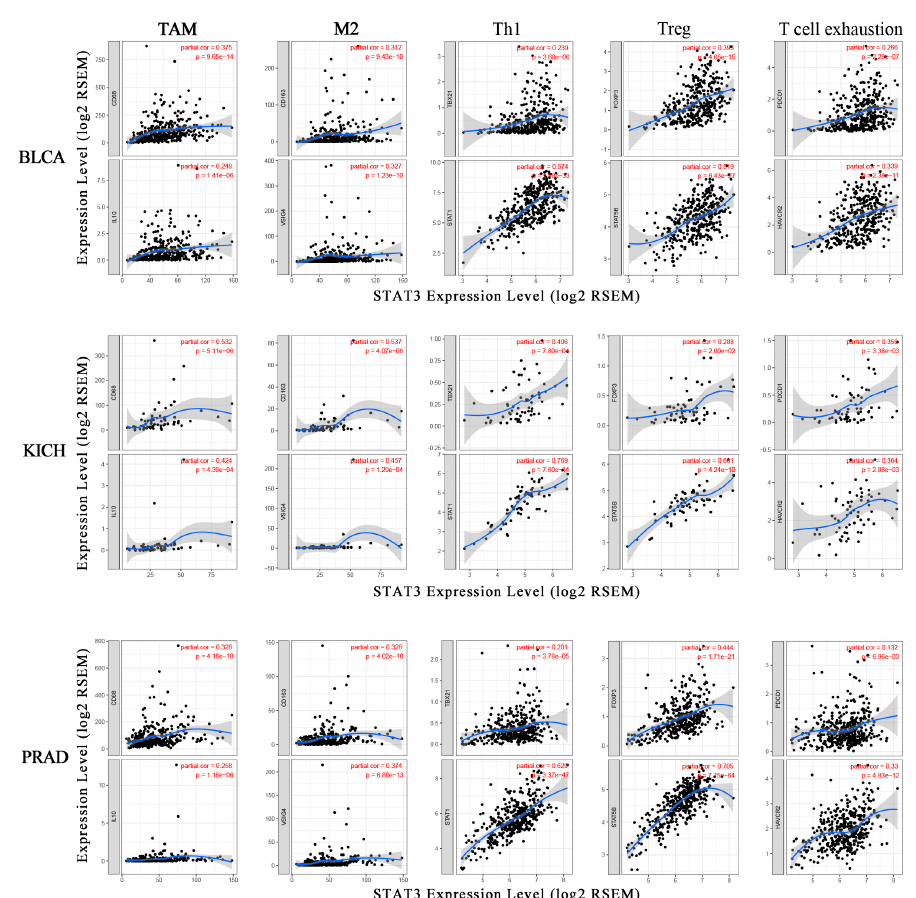
Figure 4. The correlation between STAT3 and marker genes of immune cells. The scatter plots showed the correlation between the STAT3 expression level and the gene markers of TAM (CD86, IL10); M2 macrophages (CD163, VSIG4); Th1 (TBX21, STAT1); Treg (FOXP3, STAT5B); T-cell exhaustion (PDCD1, HAVCR2) expression levels in BLCA, KICH, and PRAD.